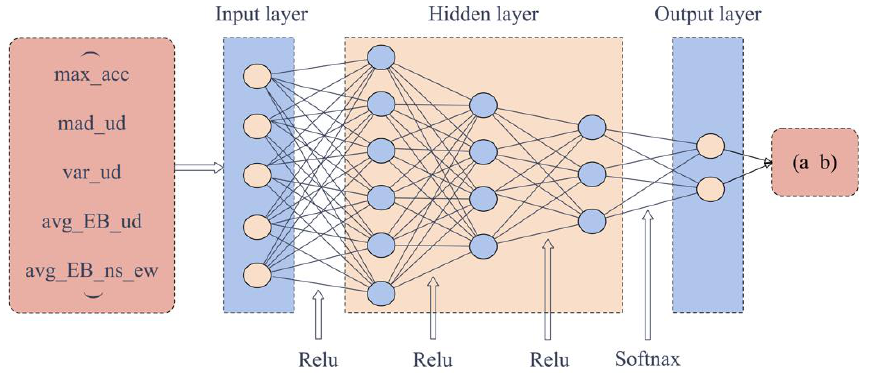
Figure 6. FCNN architecture with three hidden layers, including three hidden layers and an output layer. Max_acc, mad_ud, var_ud, avg_EB_ud and avg_EB_ns_ud are the five features, consistent with the description in Figure 5. (a b) is the classification result.